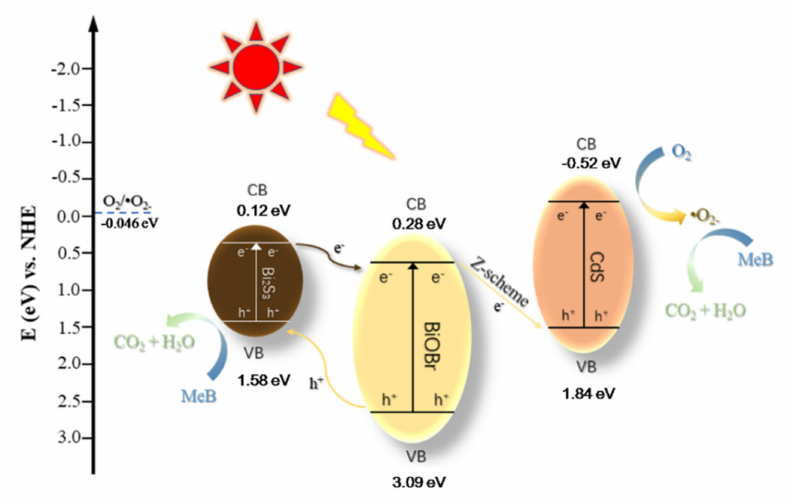
Figure 11. Proposed mechanisms for photocatalytic degradation of MeB by BiOBr/Bi 2 S 3